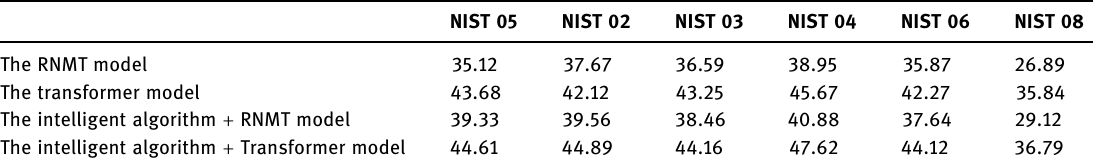
Table 2: Comparison results of BELU values on di ff erent datasets